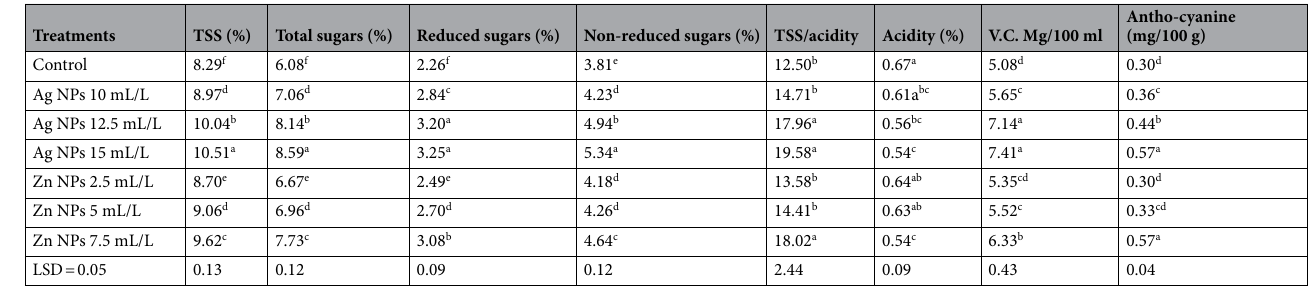
Table 3. Influence of spraying Ag and Zn NPs on TSS, total sugars, reducing sugars and non- reduce sugars, acidity percentages and anthocyanin of fruit of “Florida prince” peach cultivar during 2020 season. *Means not sharing the same letter(s) within each column, significantly different at 0.05 level of